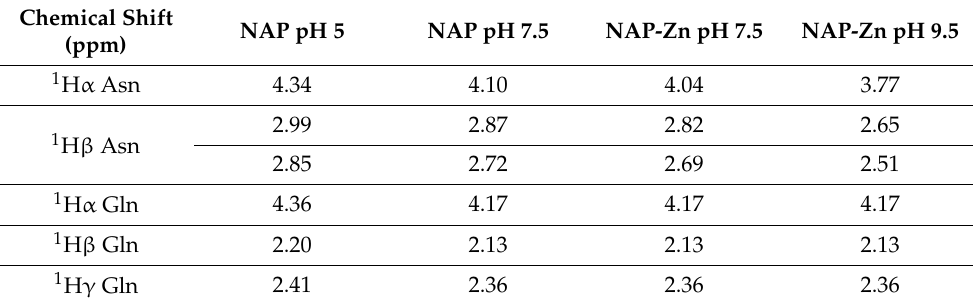
Table 2. Assignment of signal modifications in the 1 H-NMR spectra of NAP peptide at different values of pH and in the presence of zinc